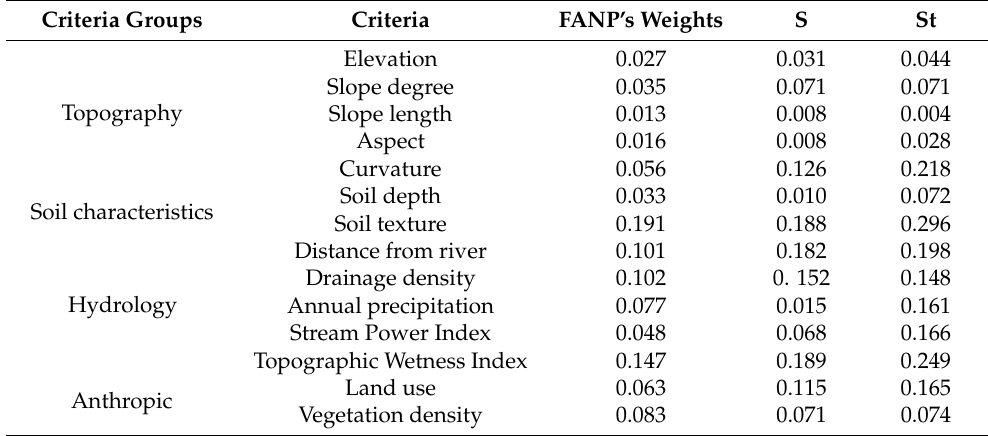
Table 6. The computed criteria weights from the FANP method for soil degradation